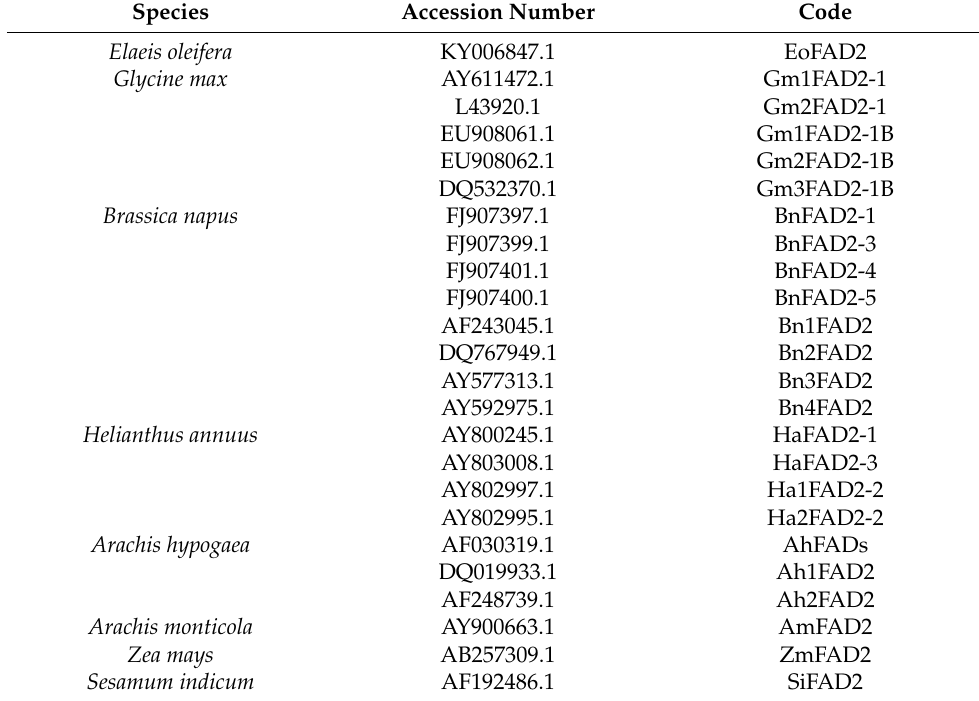
Table 1. GenBank accession numbers of 24 FAD2 gene sequences from eight oilseeds